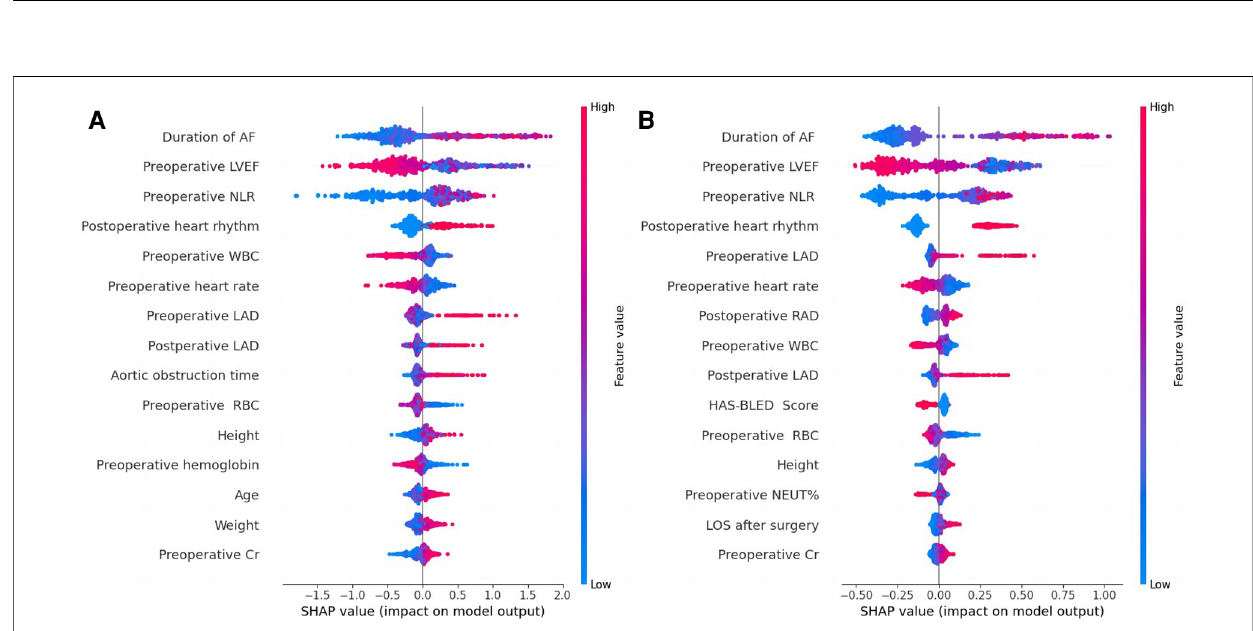
FIGURE 6 SHAP summary plots based on XGBoost model output ( A ) and catBoost model output ( B ) from the CMP-IV group. SHAP summary plots are used to visualize the impact of each feature on the model output. The plot includes a list of features on the left side and the corresponding feature values on the right side. The middle part of the plot is a cluster of coloured dots, where the red dots represent features that have a positive impact on the model output, the blue dots represent features that have a negative impact, and the purple dots represent features that have a neutral impact. The size of the dots represents the magnitude of the impact of each feature, with larger dots indicating a greater impact. The in fl uence of each feature on the outcome can be discerned by comparing the position of the dots to the reference